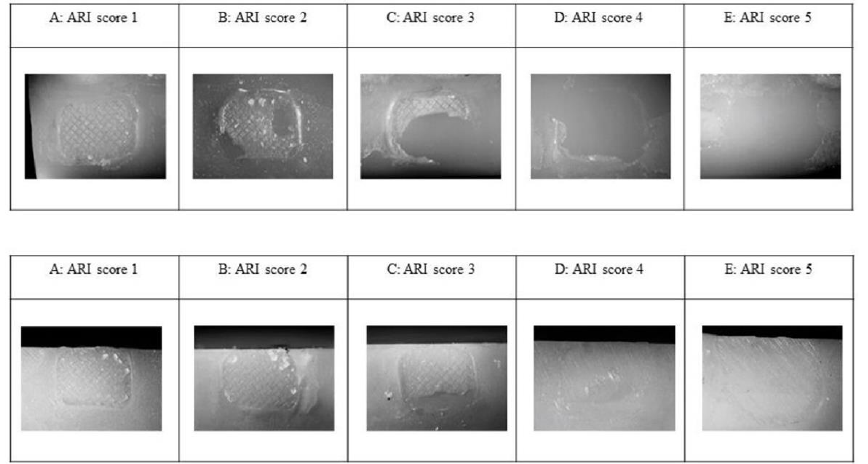
Figure 1. Optical microscope images of lithium disilicate glass ceramics (upper row) and monolithic zirconia (lower row) substrate after bracket debonding (magnification ×20). ( A – E ) are representative of 1 – 5 adhesive remnant index (ARI) scores.